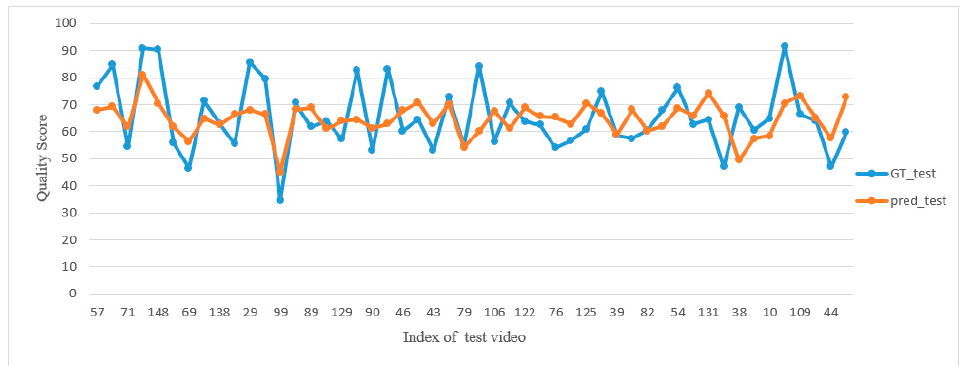
Figure 8. The predicted scores of test videos in terms of the best rank correlation coefficient obtained for the MIT figure skating dataset.